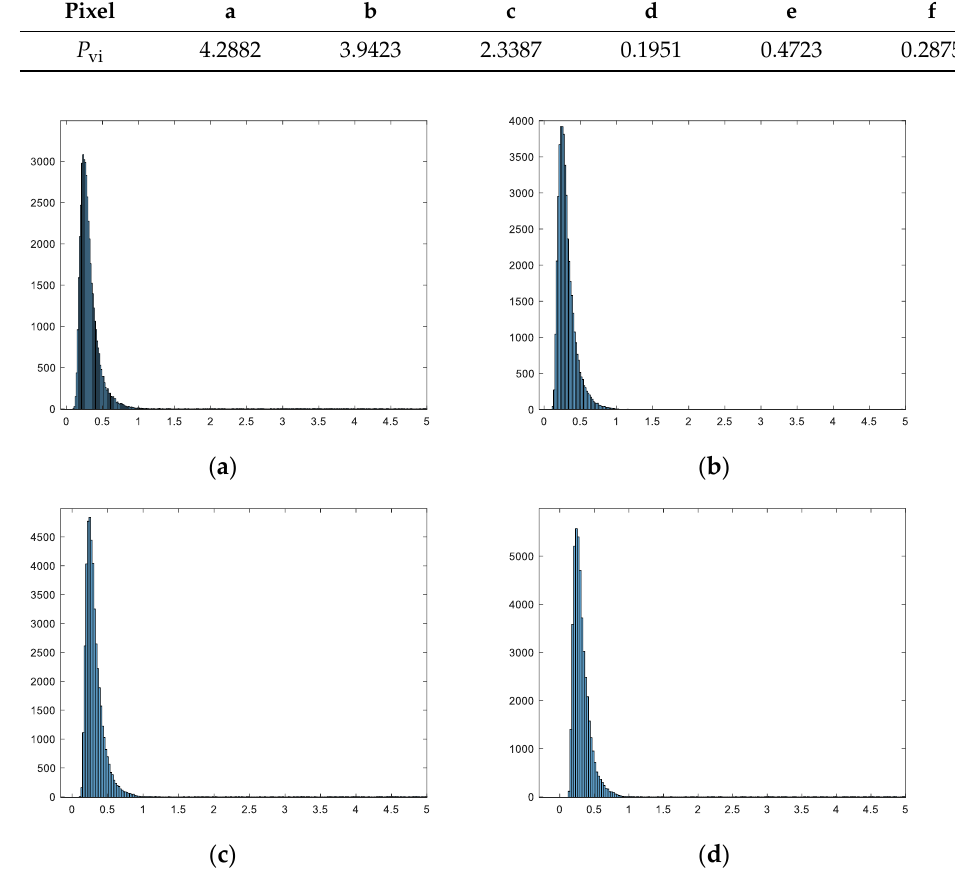
( a ) ( b ) Figure 7. ( a ) PDF estimation of 𝑃 vi and ( b ) CDF estimation of 𝑃 vi . The win in the figure represents the patch size. 4.1.3. Detection Statistic As mentioned before, the backscattering energy of the ship is dominated by the en- ergy of the double-bounce scattering. Figures 8 and 9 show several amplitude images of a small ship and a large ship on different channels. As can be seen in Figure 9, the contrast of a small target to sea clutter is higher in the HH − VV channel than in the other channels and the contrast of a large target to sea clutter is higher in the HV channel than in the other channels. Table 3 gives the peak signal-to-clutter ratios of the ship and sea clutter in dif- ferent channels. From these results, it can be seen that it is reasonable to set the detection statistic to the ensemble average of |HH − VV|·|HV|. For a keypoint detection statistic patch, the detection threshold is set according to the value of the center pixel, namely the detection statistic value of the keypoint pixel. In this paper, the threshold is set as the detection statistic value of the center pixel multiplied by 0.55 according to the experiment.